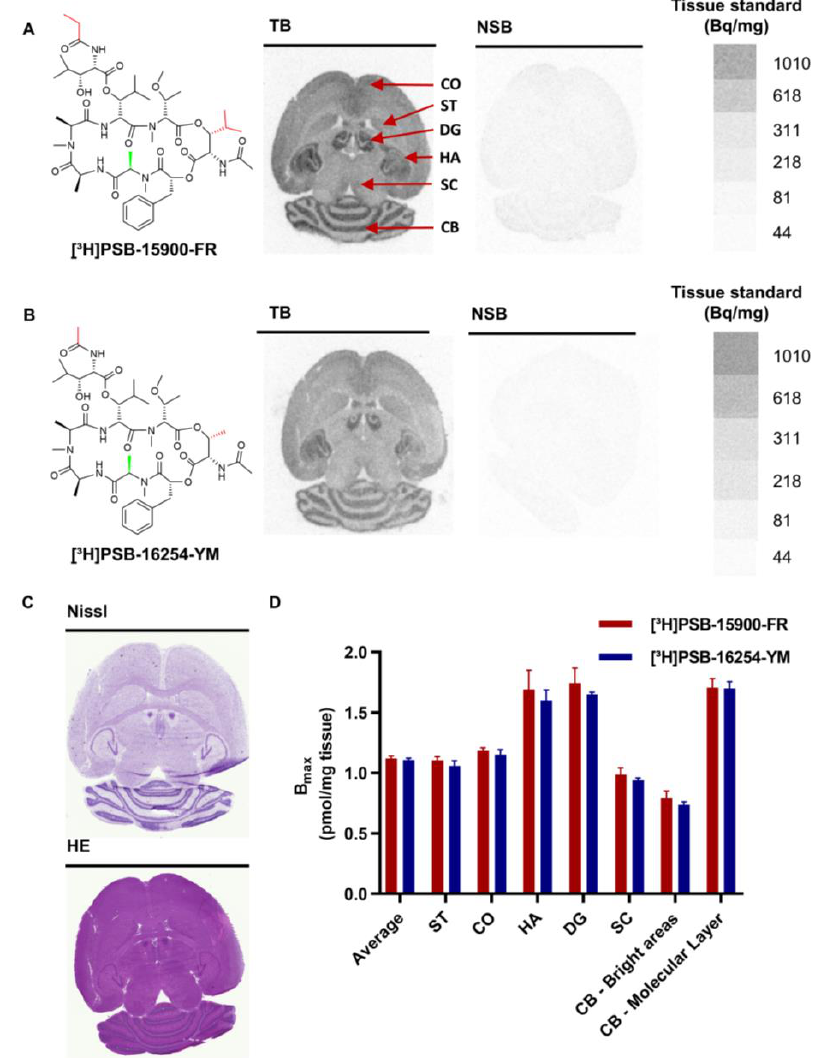
Figure 1. Chemical structures of the employed radioligands and representative autoradiography images of mouse brain sections, incubated with ( A ) [ 3 H]PSB-15900-FR and ( B ) [ 3 H]PSB-16254-YM. Images display total radioligand binding (TB) and non-specific binding (NSB; determined in presence of 5 µ M FR). Organ slices were incubated with 10 nM of the indicated radioligand for 1 h at room temperature. Tissue equivalent standards for each radioligand are displayed on the righthand side. Red arrows point to the indicated brain regions: ST, striatum; CO, cortex; HA, hippocampus; DG, dentate gyrus; SC, superior colliculus; CB, cerebellum. ( C ) Brain sections were stained with cresyl violet (Nissl) and hematoxylin-eosin (HE). ( D ) B max values obtained by densitometric analysis of radioligand